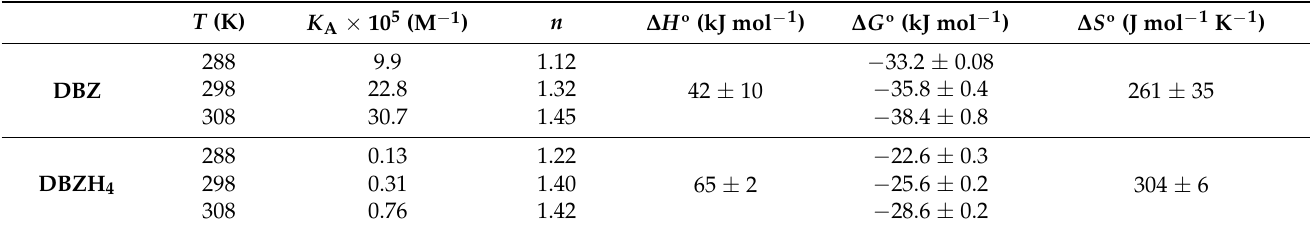
Table 2. Association constants and thermodynamic parameters for the interaction between BSA and complexes DBZ and DBZH 4 at different